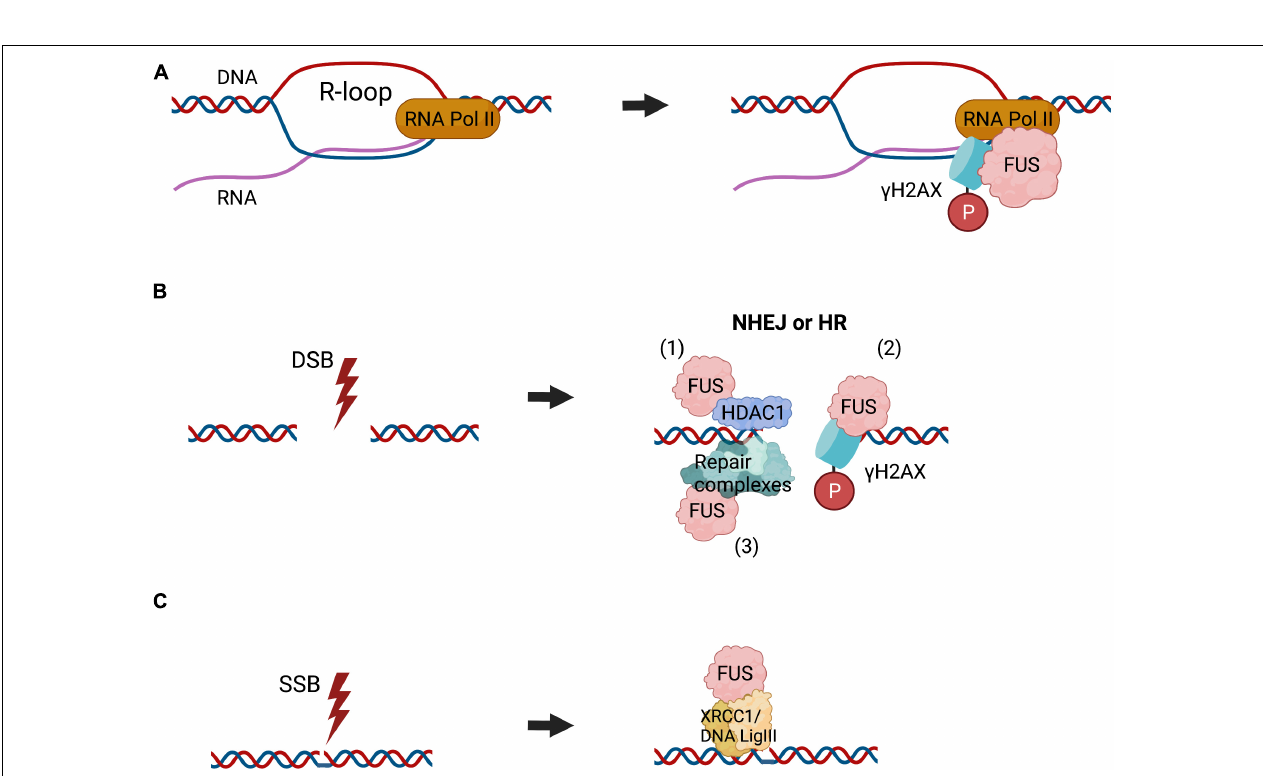
FIGURE 2 | The roles of FUS in DNA repair. FUS is implicated in diverse DNA repair pathways. (A) FUS functions in the repair of R-loop associated DNA damage, formed during transcription, where it binds to γ H2AX foci and RNA polymerase II (RNA Pol II), similar to TDP-43. (B) FUS is recruited to the sites of DSBs, which can be repaired by NHEJ or HR, although in neurons NHEJ is the most important mechanism. FUS interacts directly with HDAC1 to regulate DSB repair (1). It also participates in the phosphorylation of histone H2AX (2) and likely facilities the assembly or stabilisation of DNA repair complexes (3). (C) FUS is also implicated in BER DNA repair, by facilitating the assembly or stabilisation of DNA repair complexes. This also includes recruitment of the XRCC1/DNA ligase III α to repair oxidatively damaged bases.